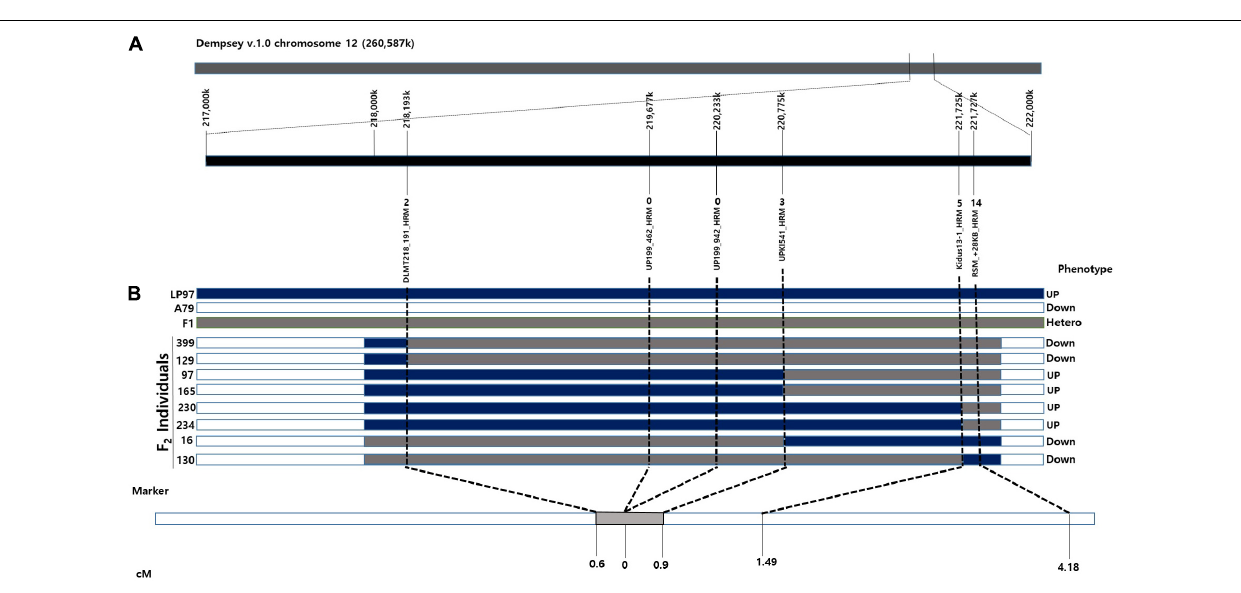
Based on the fine mapping results, the DLMT218_191 marker was found to be located in the region of 218 Mbp along chromosome 12 and the RSM_ + 28KB marker was located at